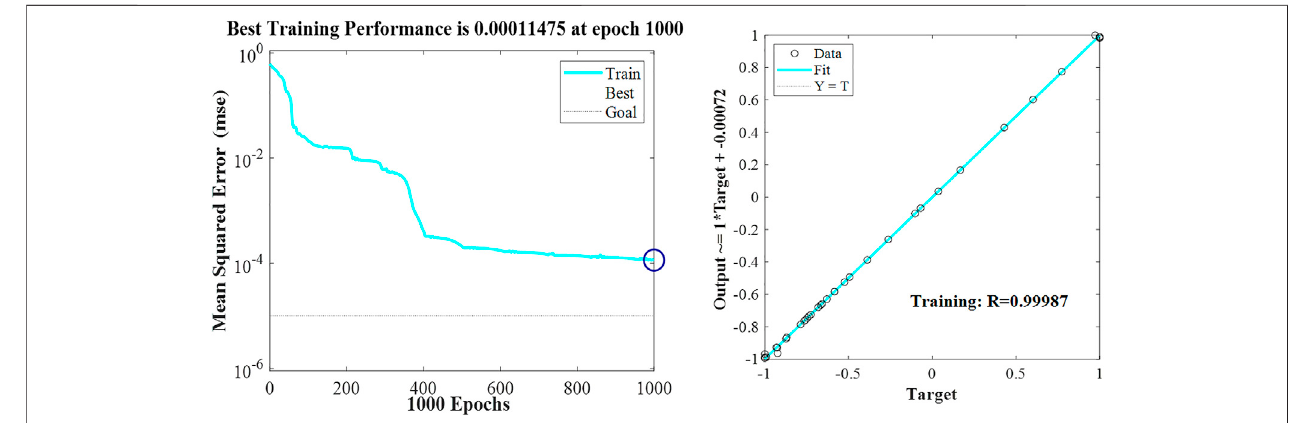
FIGURE 6 | Error convergence curve and fi tting